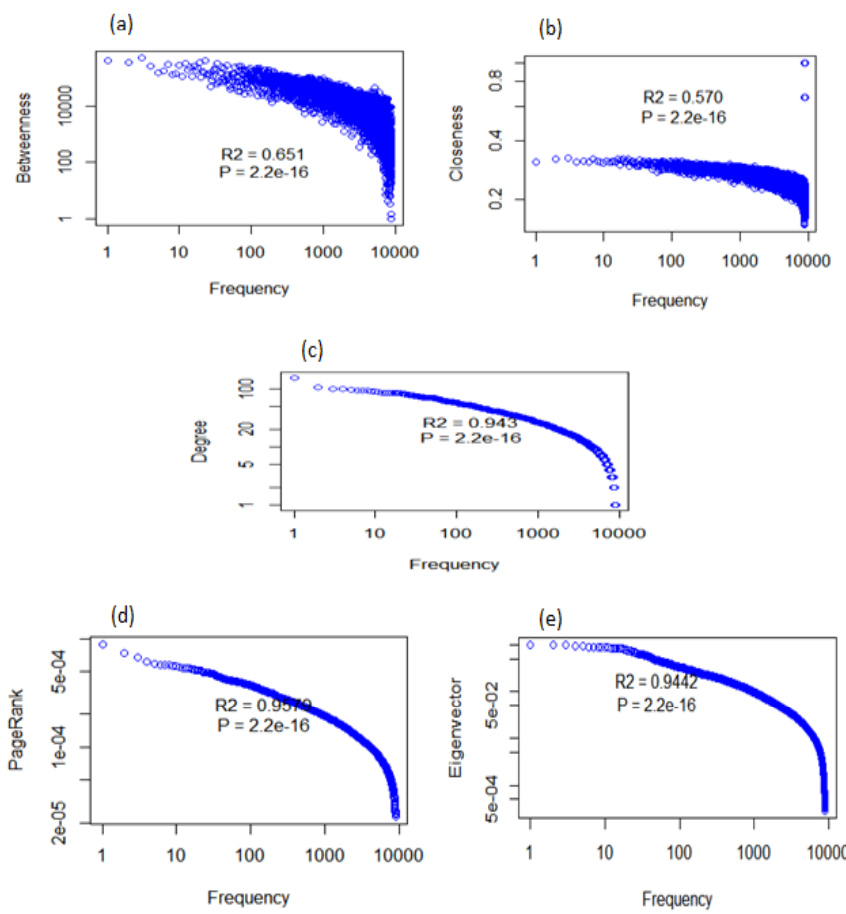
Figure 2. Power law analysis of ( a ) betweenness, ( b ) closeness, ( c ) degree, ( d ) PageRank and ( e ) Eigenvector.